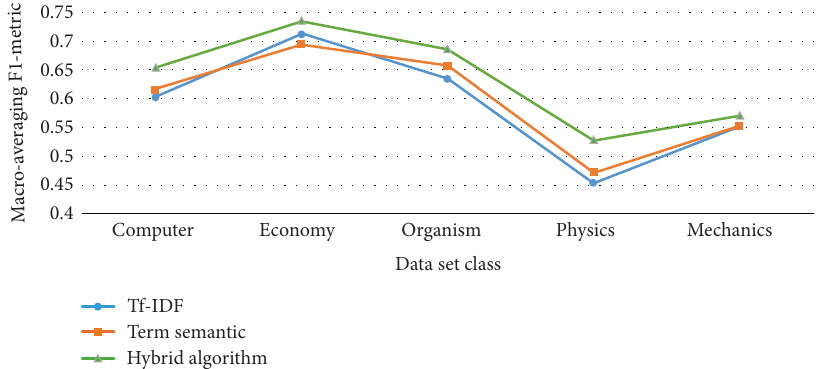
Figure 13: Macroaverage F1-metric analysis of three methods in DKM